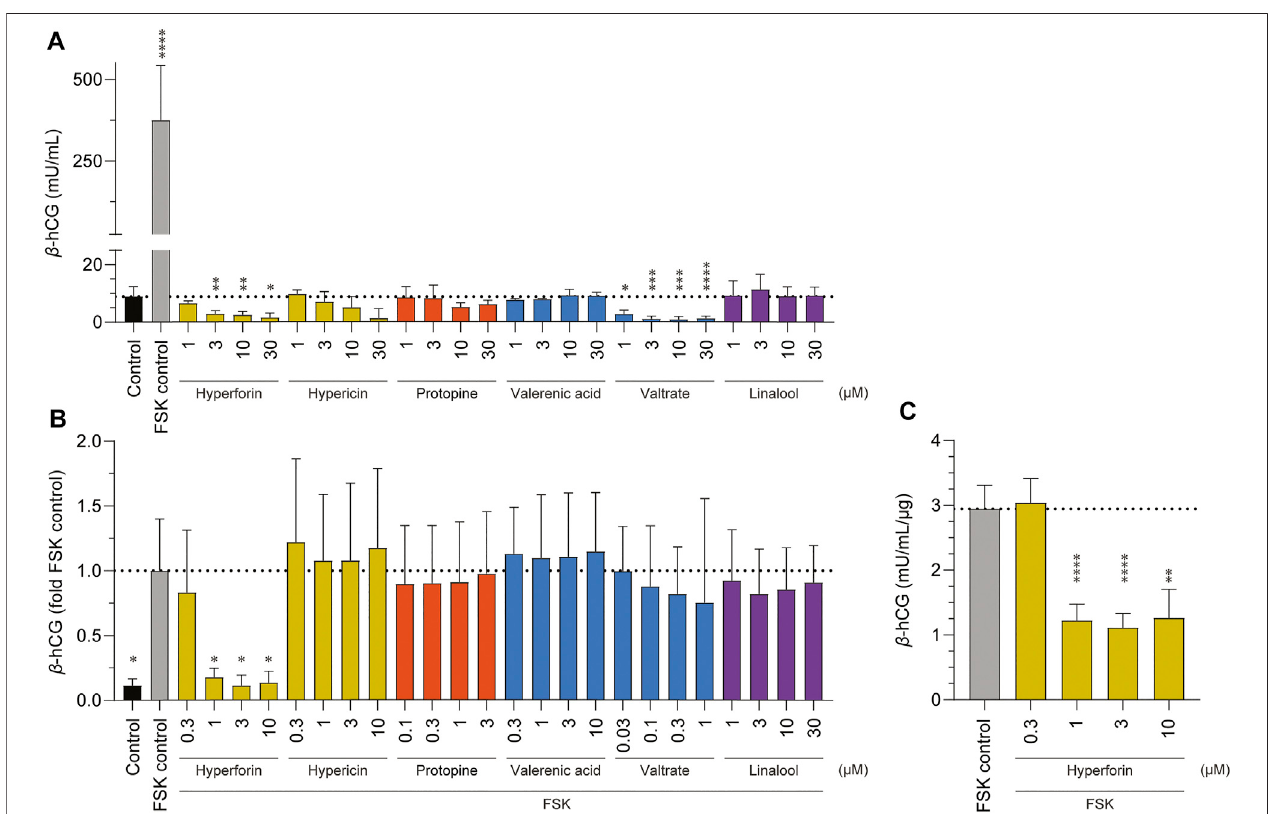
FIGURE6| Effectsofvariousphytochemicalsontheproductionof β - hCGinBeWob30cells.Controlconsistedofcellculturemediacontaining0.2%DMSO;5 µM forskolin (FSK) was used for the FSK control. Data are presented as mean ± SD of at least three independent experiments ( n = 3 – 4; in triplicate): * p < 0.05. (A) Comparison of β - hCG secretion of BeWo b30 cells upon 48-h treatment with increasing concentrations of phytochemicals (1, 3, 10, and 30 µM) vs. FSK control. (B) Effects on inhibition of FSK-induced differentiation of BeWo b30 cells. FSK treatment (5 µM) led to increased β - hCG levels in all phytochemicals after an incubation of 48 h, except for hyperforin, where the FSK-induced differentiation was inhibited at concentrations of 1, 3, and 10 µM. Based on preliminary data (not shown),different concentration gradients (ranging from 0.03 up to30 µM)of phytochemicals were individuallydetermined in advance (before exposure). Cells were pre- treated with the different phytochemicals for 24 h, before the addition of FSK for another 24 h. (C) Effects of hyperforin on inhibition of FSK-induced differentiation of BeWo b30cellsnormalizedperamountofprotein( μ g). FSKtreatment (5 µM)ledtodecreased β - hCGlevels afteranhyperforinincubationof48 hat concentrationsof1, 3, and 10